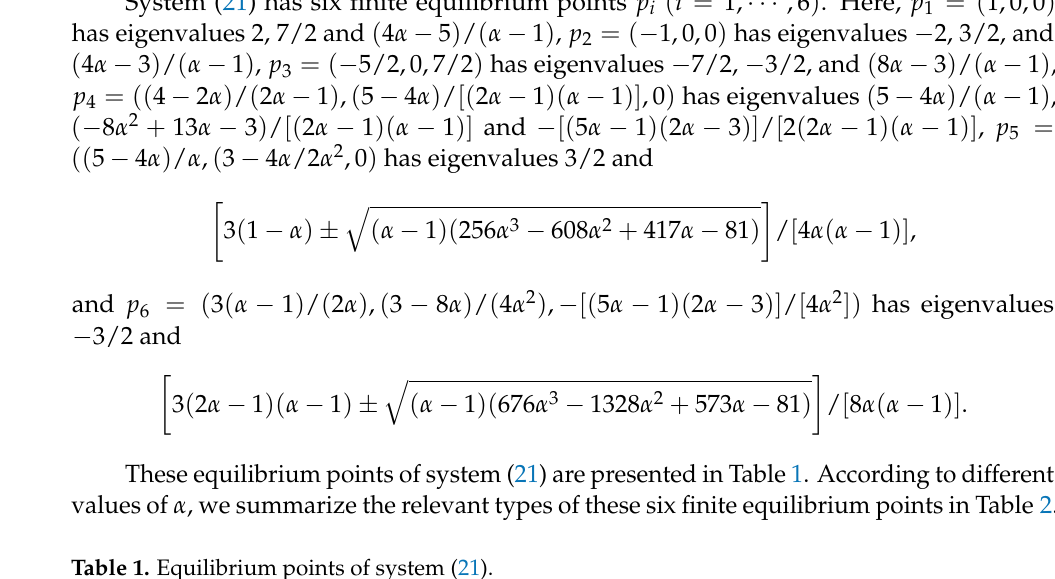
Table 1. Equilibrium points of system (21).